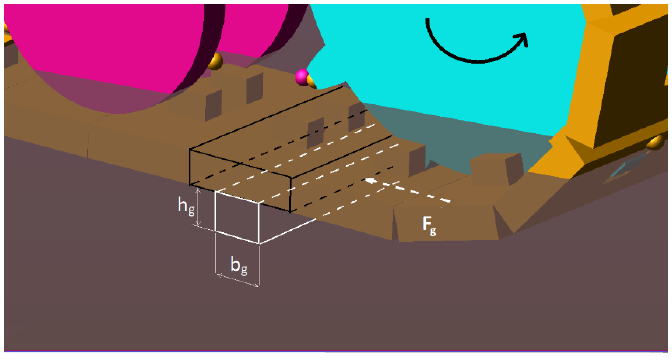
Figure 14. Grousers shape and